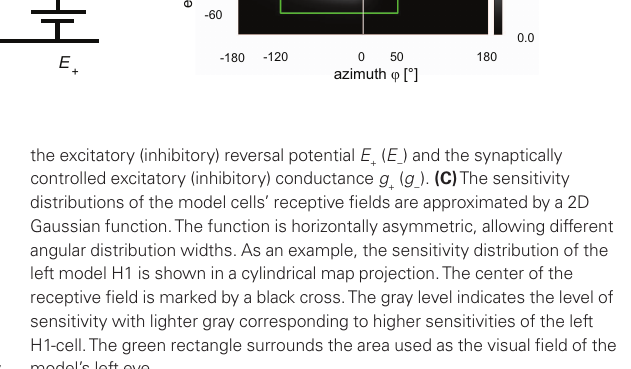
spatially convolved with a Gaussian low-pass filter ( σ = 2 ° ) to